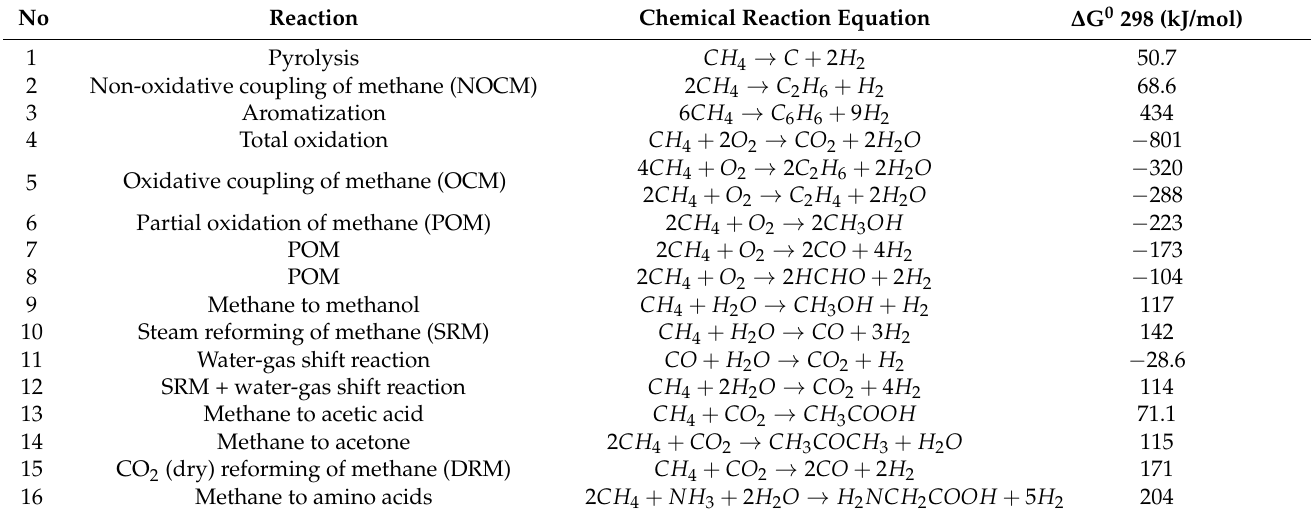
Table 1. Change of Gibbs free energy for various methane reactions [18]. Reproduced with permission from Yuliati & Yoshida. Copyright © 2022 The Royal Society of